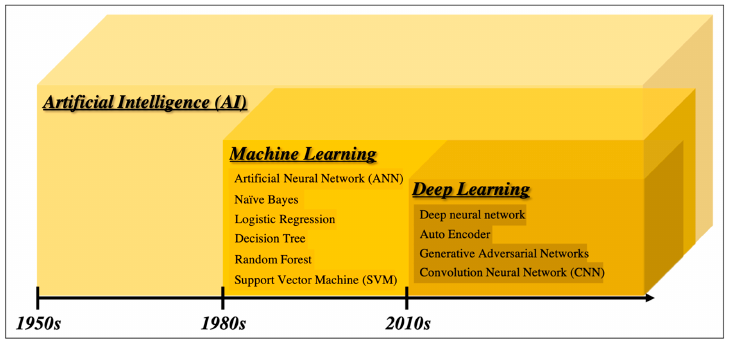
Figure 1. Overview of the development of artificial intelligence.